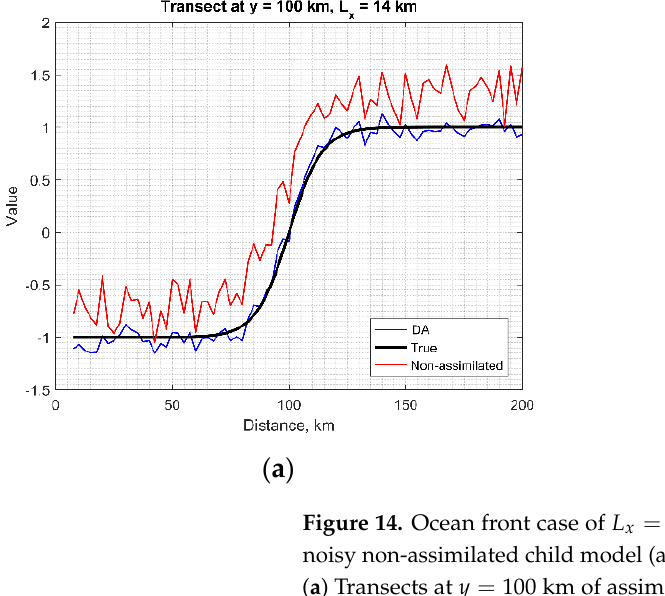
Figure 14. Ocean front case of 𝐿 𝑥 = 14 km, with noisy parent model (added noise STD = 0.1) and noisy non-assimilated child model (added noise STD = 0.15, bias = 0.3 and shift of 4 km to the west). ( a ) Transects at 𝑦 = 100 km of assimilated (blue), non-assimilated (red) child models, and the true field (black), ( b ) RMSE calculated for non-assimilated (black) and assimilated (blue) child models and the ratio between them at different front steepness.